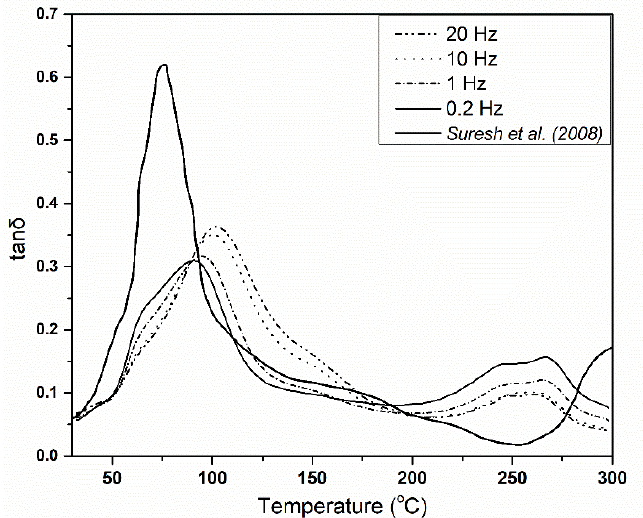
Figure 1. Loss factor (tan δ ) versus temperature of commercial PAN fibers enriched with literature data [90] .